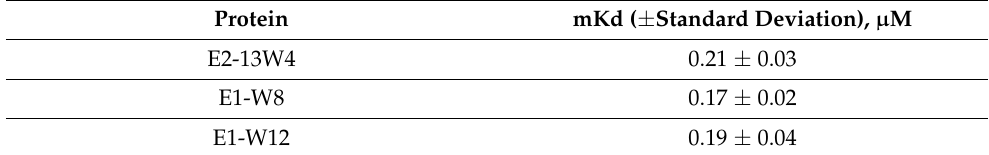
Table 6. Mean geometric dissociation constants of MBS–Gd 3+ complexes of proteins in 10 mM HEPES (pH 7.0) at 25 °C.